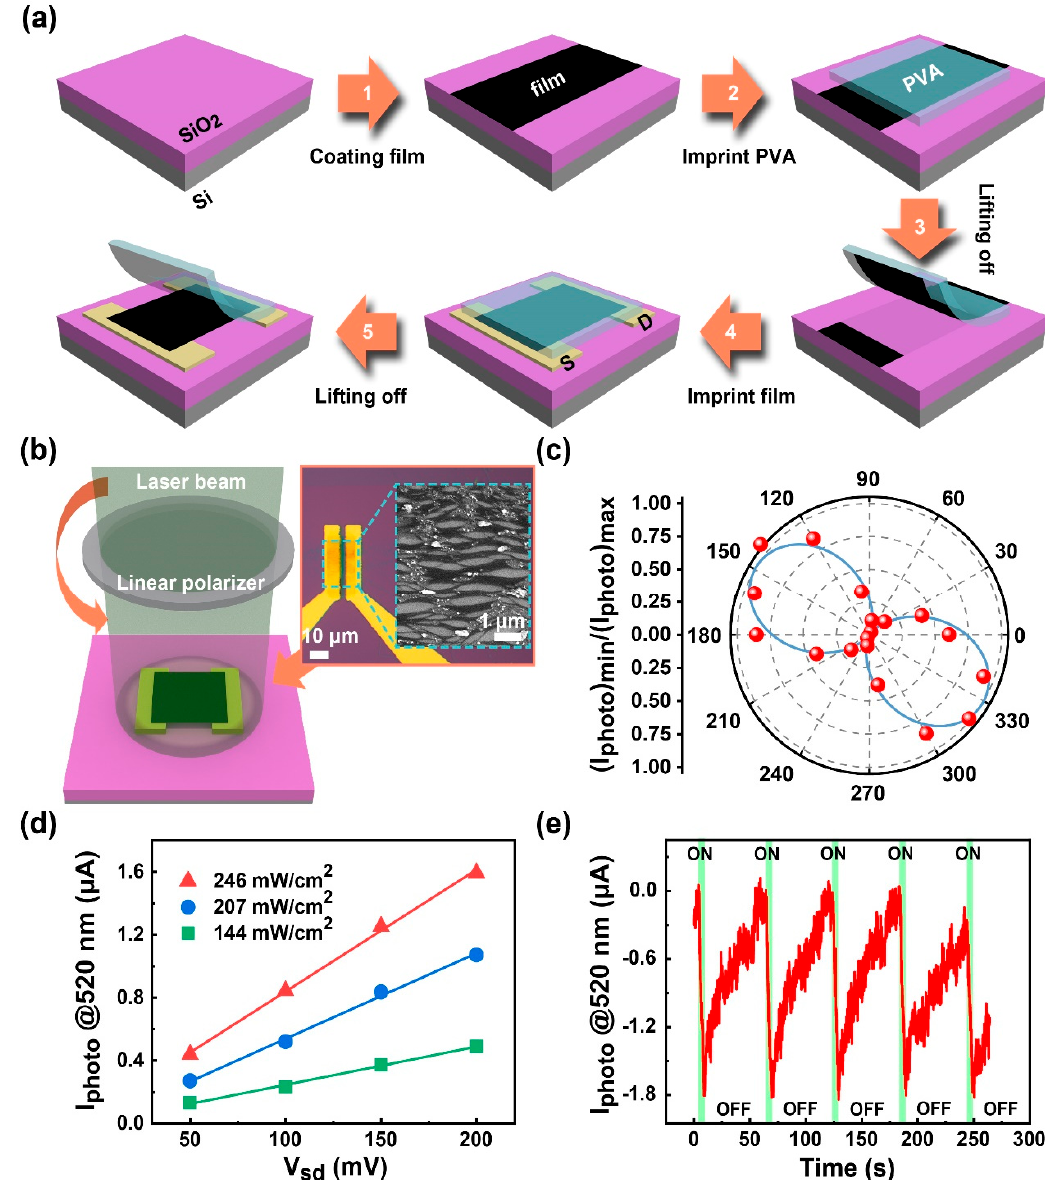
Figure 6. ( a ) A regular 2D film transferring process applied to the SWCNT film; ( b ) Schematic of photoresponse measurement for a two-terminal device; ( c ) Polarization-dependent photocurrent observed for aligned SWCNTs; ( d ) Photocurrent as a function of bias voltage under different incident power; and ( e ) Temporal photoresponse of I photo measured under V sd of 200